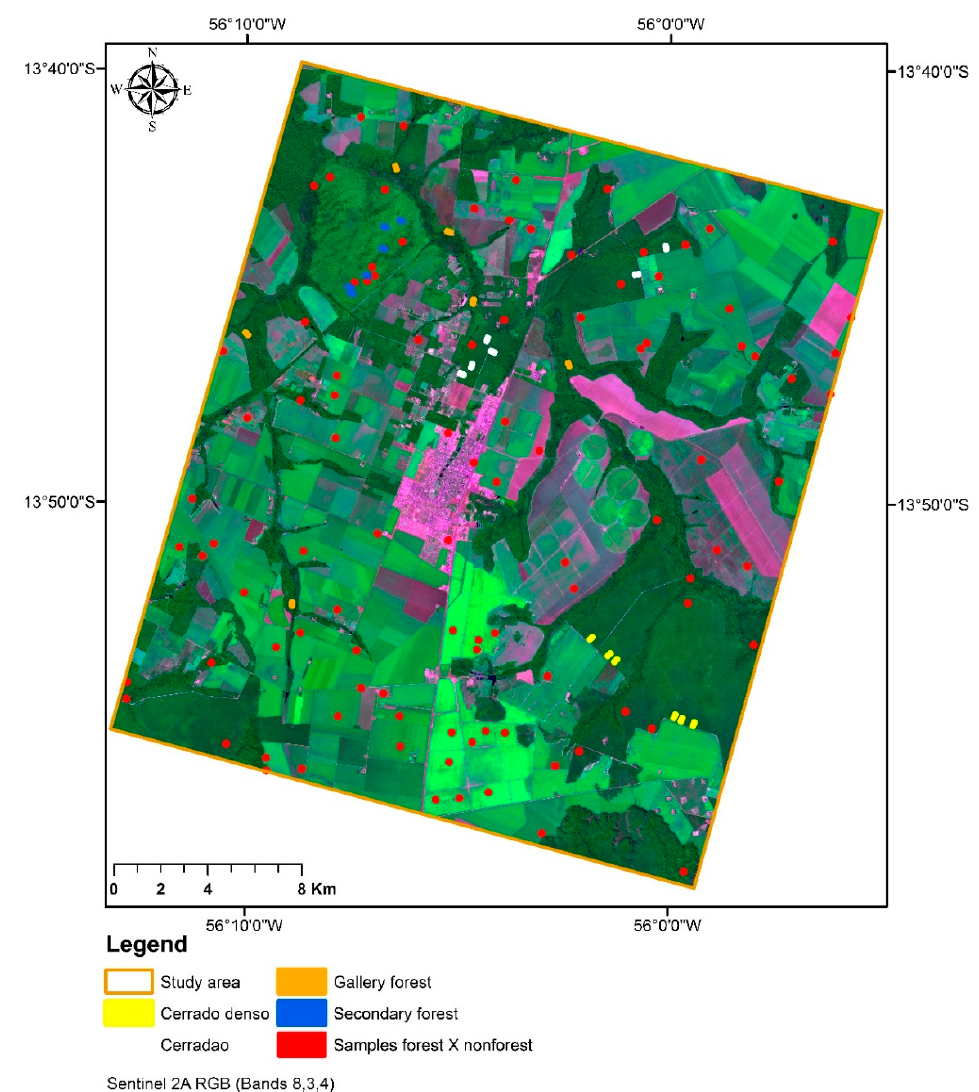
Figure 5. Distribution of Random Forest and non-forest samples and forest type samples (4 classes) in the study area, on top of a false color composition of Sentinel 2A Band 3, 4, and 8 (07 July 2017).